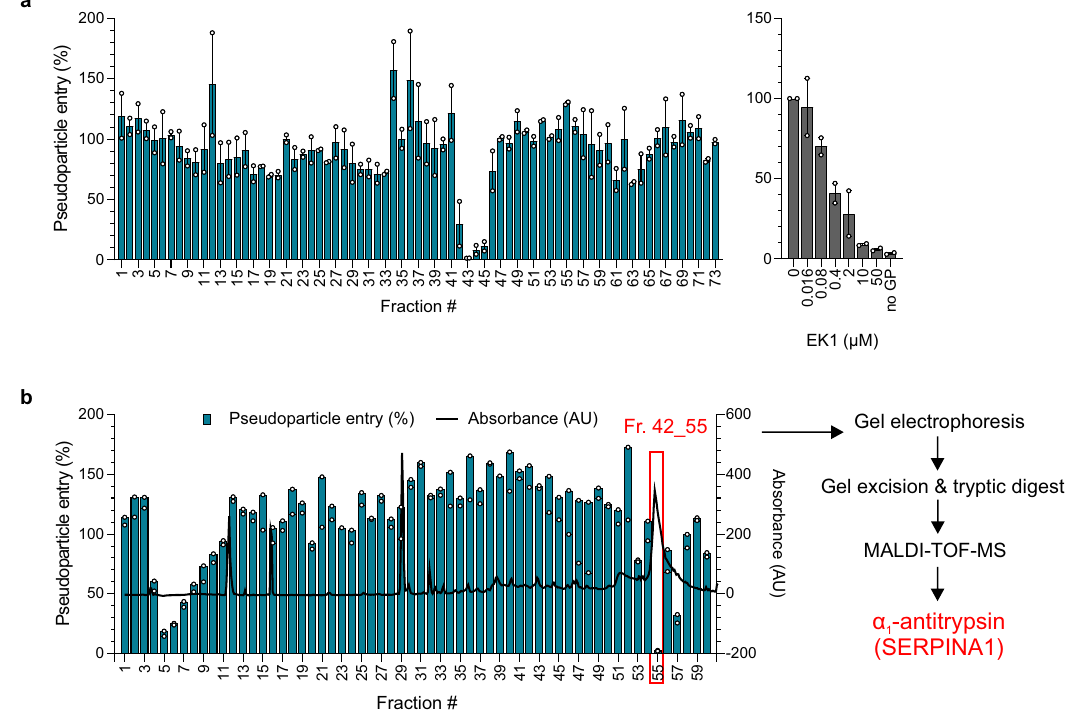
Fig. 1 Identi fi cation of α 1 AT as SARS-CoV-2 inhibitor. a Caco2 cells were treated with peptide/protein containing fractions of the bronchoalveolar lavage library (or EK1 peptide as inhibitor control) and transduced with luciferase-encoding lentiviral SARS-CoV-2 spike pseudoparticles. b Caco2 cells were treated with subfractions of mother fraction 42 (see a ) of the bronchoalveolar lavage library and transduced with lentiviral SARS-CoV-2 spike pseudoparticles. Blue columns represent pseudoparticle entry and black line absorbance at 280 nm of the corresponding fraction. Transduction rates in a and b were determined 2 days after the addition of pseudoparticles by measuring luciferase activities in cell lysates. The means± SEM from n = 2 ( a ) or individual datapoints from n = 1 ( b ) independent experiments are shown, each performed in biological duplicates. The active fraction 42_55 (red box) was analyzed via gel electrophoresis, gel excision, tryptic digest, and MALDI-TOF-MS to identify α 1 AT, a serine protease inhibitor (serpin). Source data are provided as a Source data fi